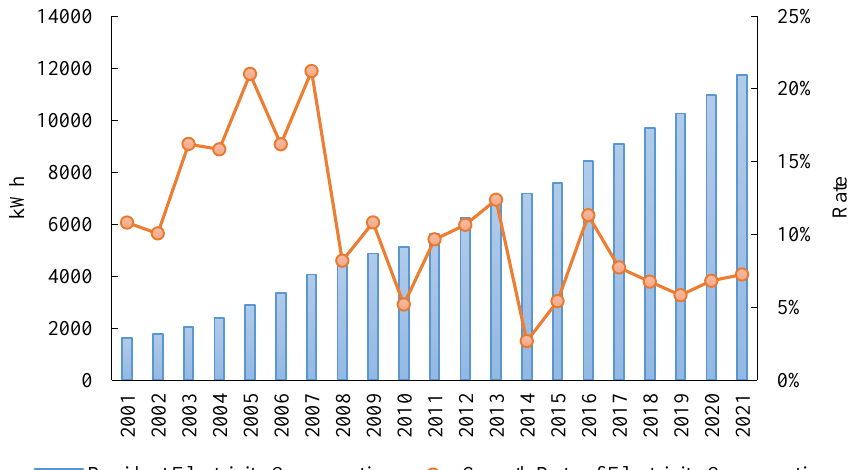
Figure 1. 2001–2021 China resident electricity consumption and growth rate. Data source: China National Bureau of Statistics.